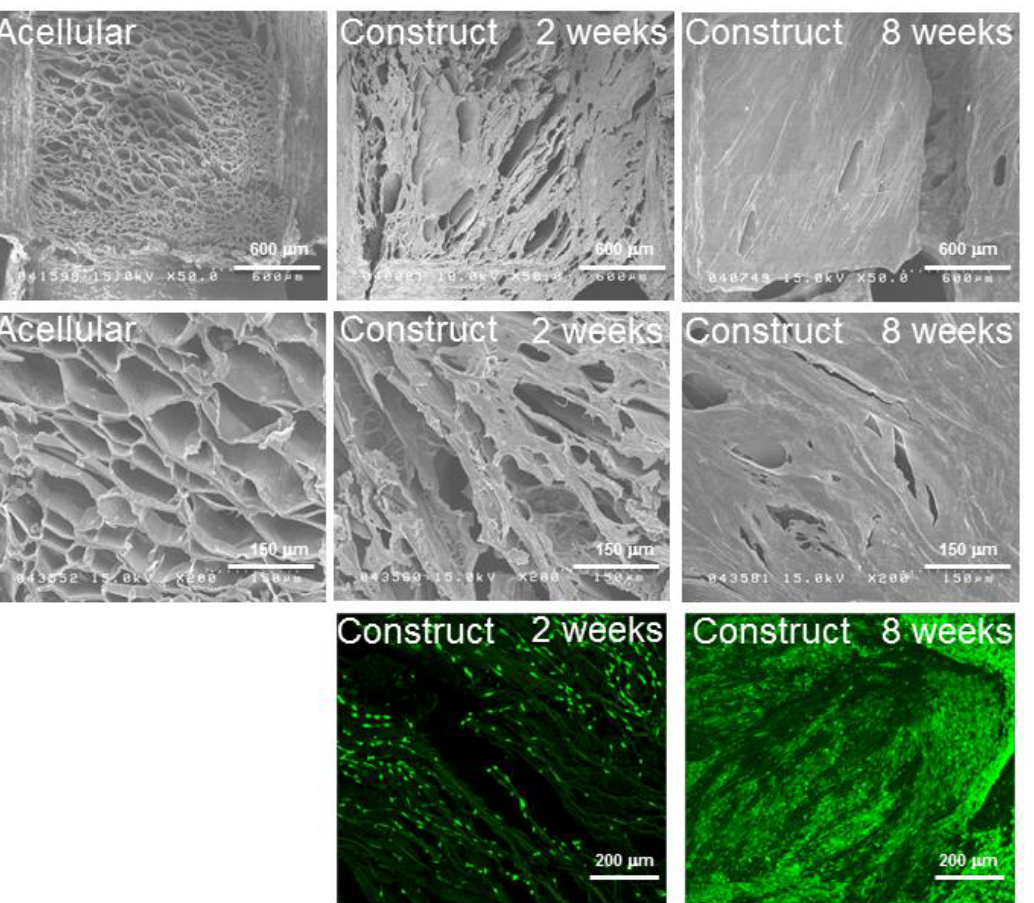
Figure 4. Scanning electron microscopic observations of the acellular SF scaffold ( A , D ), and SF scaffold-chondrocytes constructs ( B , C , E and F ) cultured in vitro . ( A – C ) top view (bar = 600 µm); ( D – F ) cross-section view (bar = 150 µm). The penetrating channels and surface channels could be seen from the top view; ( G , H ) Confocal microscopic observations of the SF scaffold-chondrocyte constructs cultured in vitro via the live/dead assays (bar = 200 µm). The leaf-like micro-structures of SF scaffolds are seen as the wavy lines dispersed between the round and bright green cells.